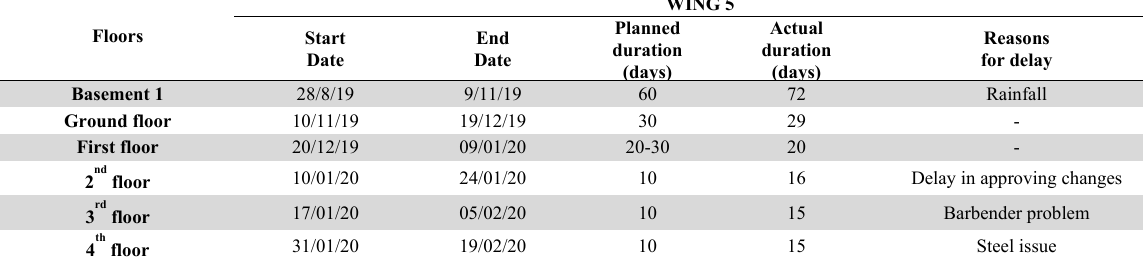
Planned and Actual Duration of Wing 5